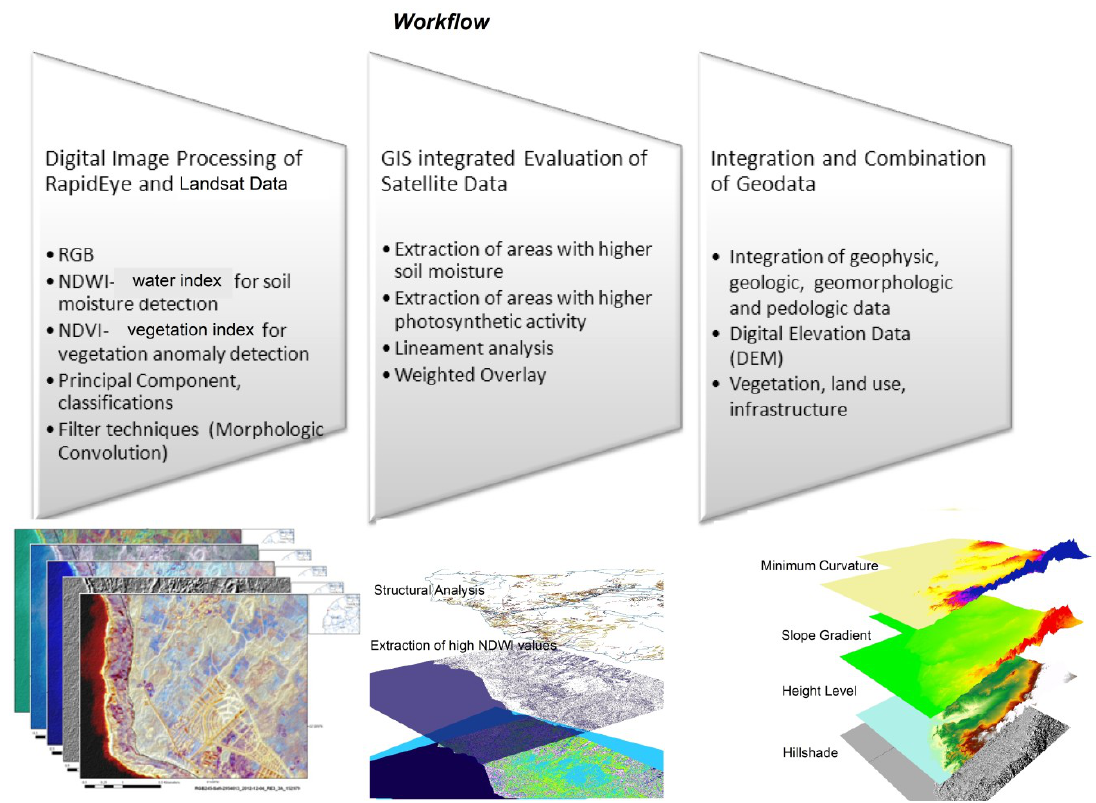
Figure 9. Geographic information system (GIS) integrated evaluation of different